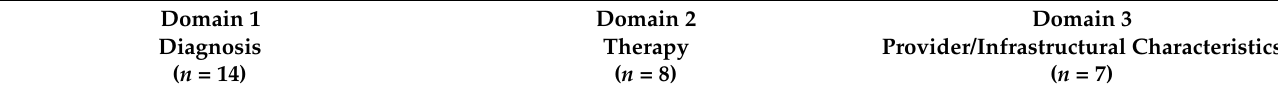
Table 9. Guideline-based indicators for adult MDS